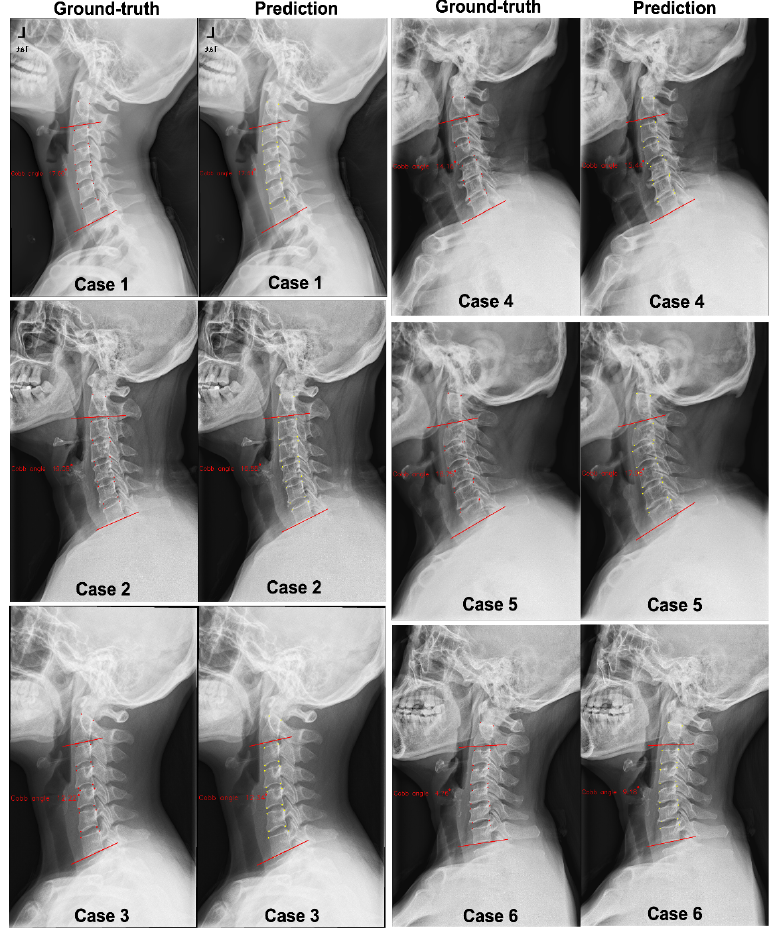
Figure 3. Six samples of landmark detection and Cobb angle estimation using our model and the ground truth on CS799.